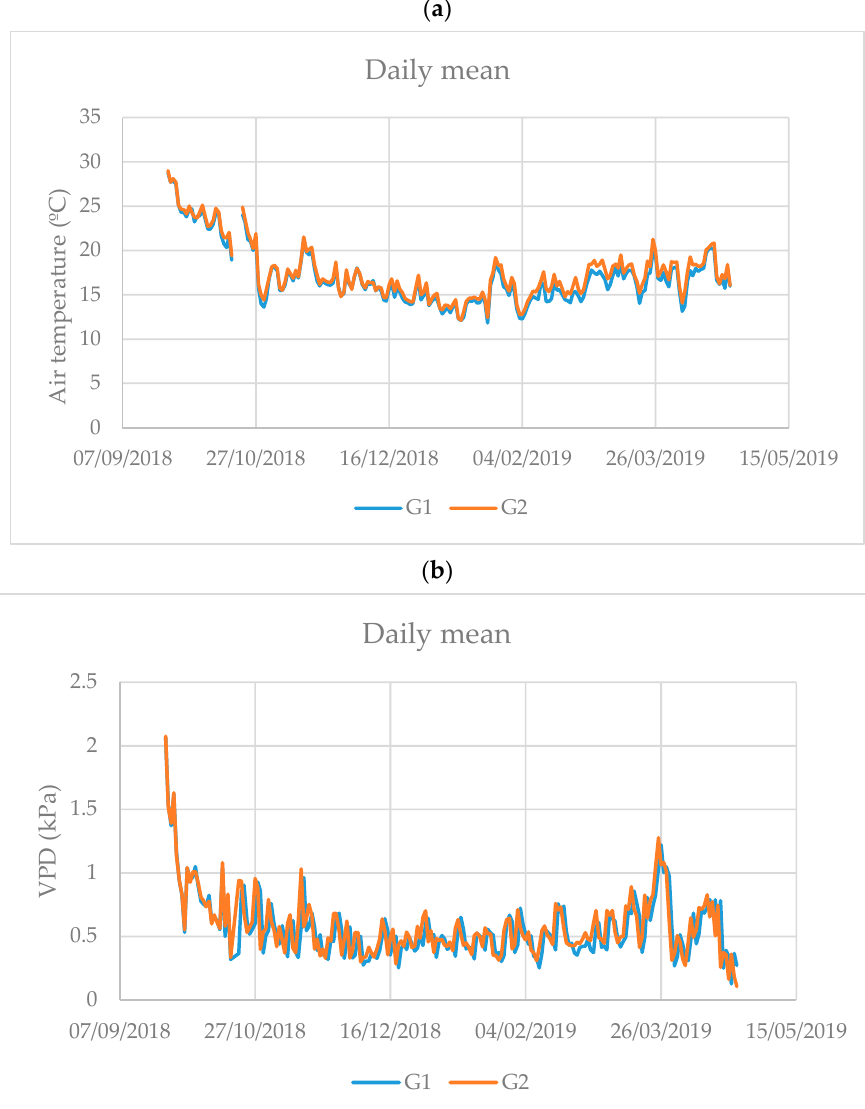
Figure 3. Daily mean air temperature ( a ) and daily mean air vapor pressure deficit (VPD) ( b ) inside of the two greenhouse during the growing seasons.